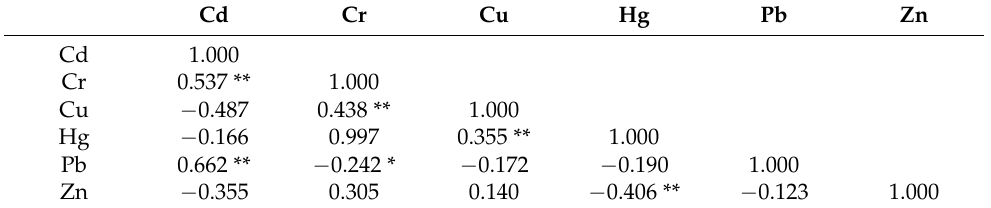
Table 10. Pearson correlation matrix of heavy metals in surface water.